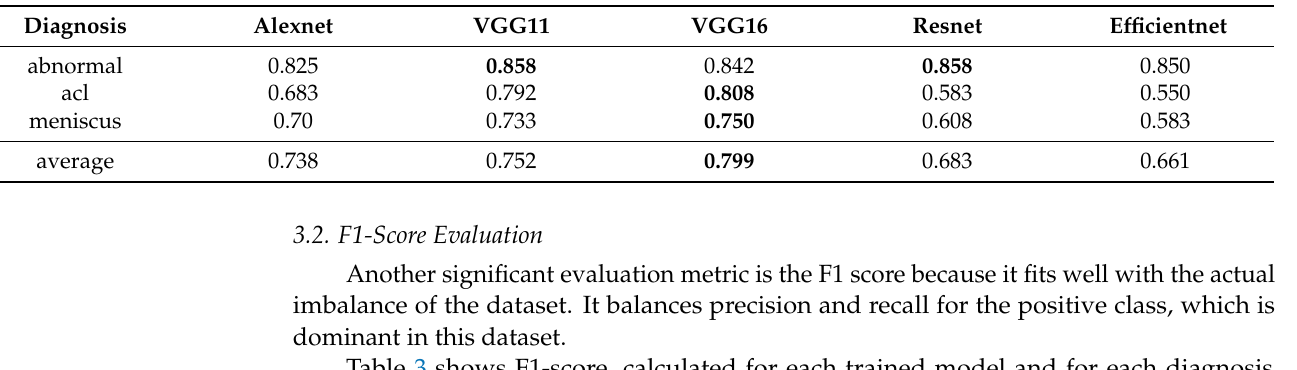
Table 2. Accuracy comparison per model, per diagnosis (threshold = 0.5). Maximum values are highlighted in bold.